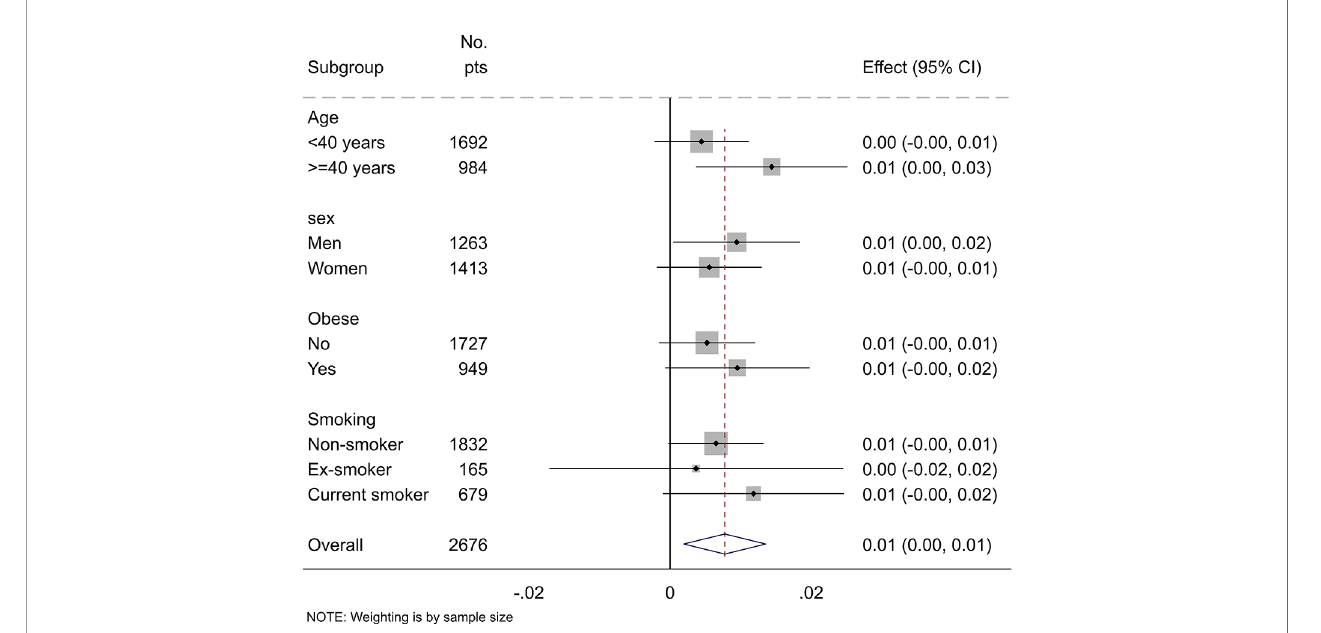
FIGURE 3 | Subgroup analysis of the association between uric acid and total body BMD strati fi ed by age, sex, obesity, and smoking status. Values represent the regression coef fi cients per SD change of uric acid. Models adjusted for age, gender, BMI, serum vitamin D, alkaline phosphatase, eGFR, and smoking status. Strati fi cation variables were not adjusted in corresponding